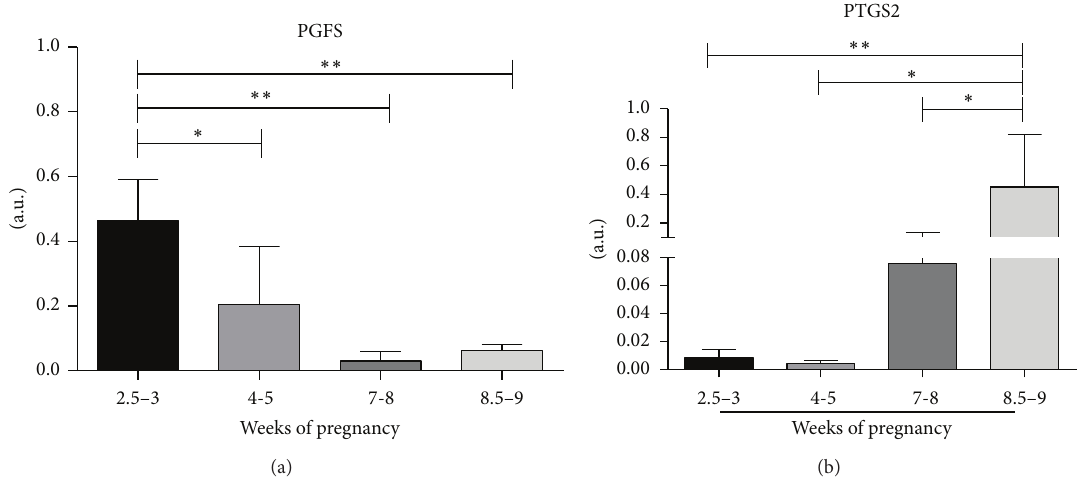
Figure 3: PGFS (AKR1C3) and PTGS2 mRNA expression. Time-dependent expression of feline PGFS (a) and PTGS2 (b) as determined by Real-Time PCR. Asterisks indicate statistical differences between expression levels during the course of pregnancy ( ∗ 𝑃 < 0.05 , ∗∗ 𝑃 < 0.001 ).